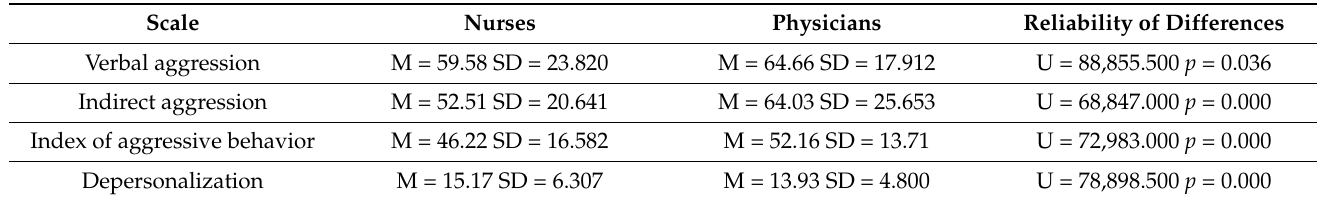
Table 13. Assessment of the average values of aggression (verbal and indirect), aggressive behavior, and depersonalization in COVID-19 ICU HCWs. M is the mean value, SD is the standard deviation, U is the Mann–Whitney criterion, and p is the significance